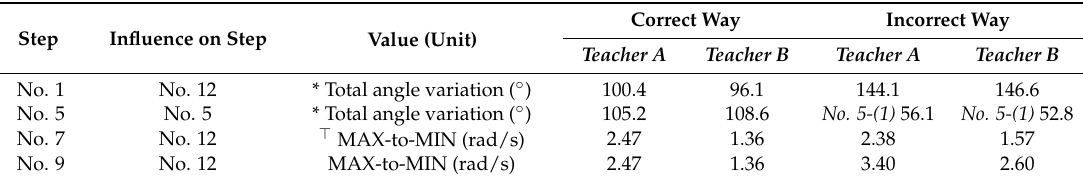
Table 3. Results of rotational